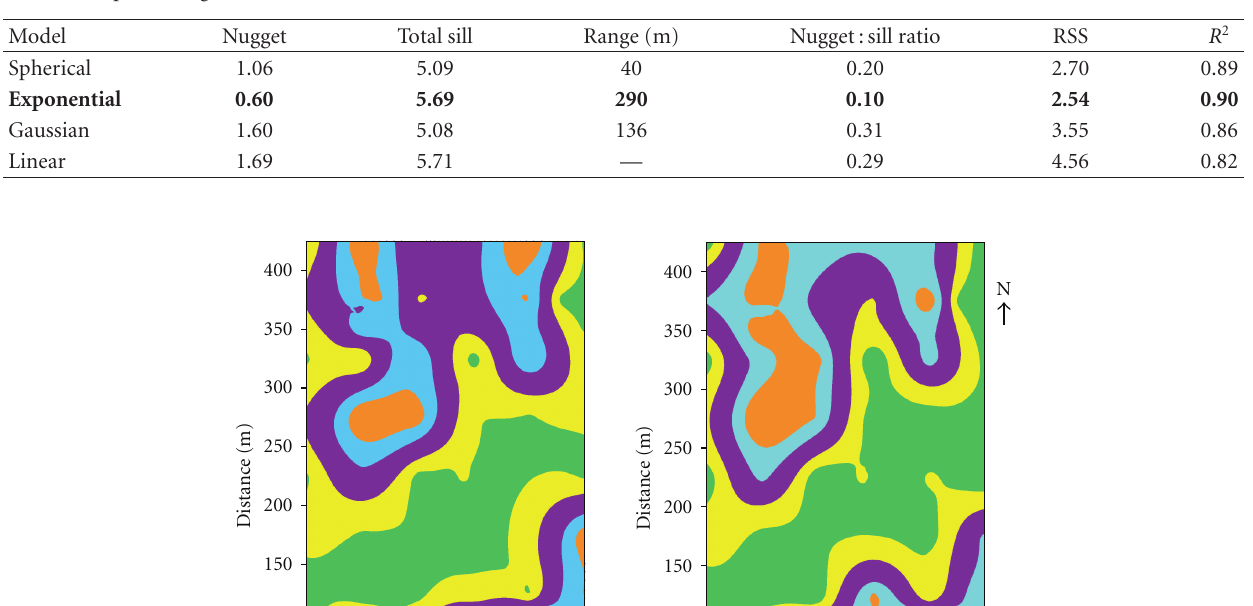
Table 10: Fitted semivariogram models, nugget, total sill, range, nugget to sill ratio, residual sum of square (RSS), and R 2 value of EC at 20–40 cm depth during 2010 (best fitted model is in bold).